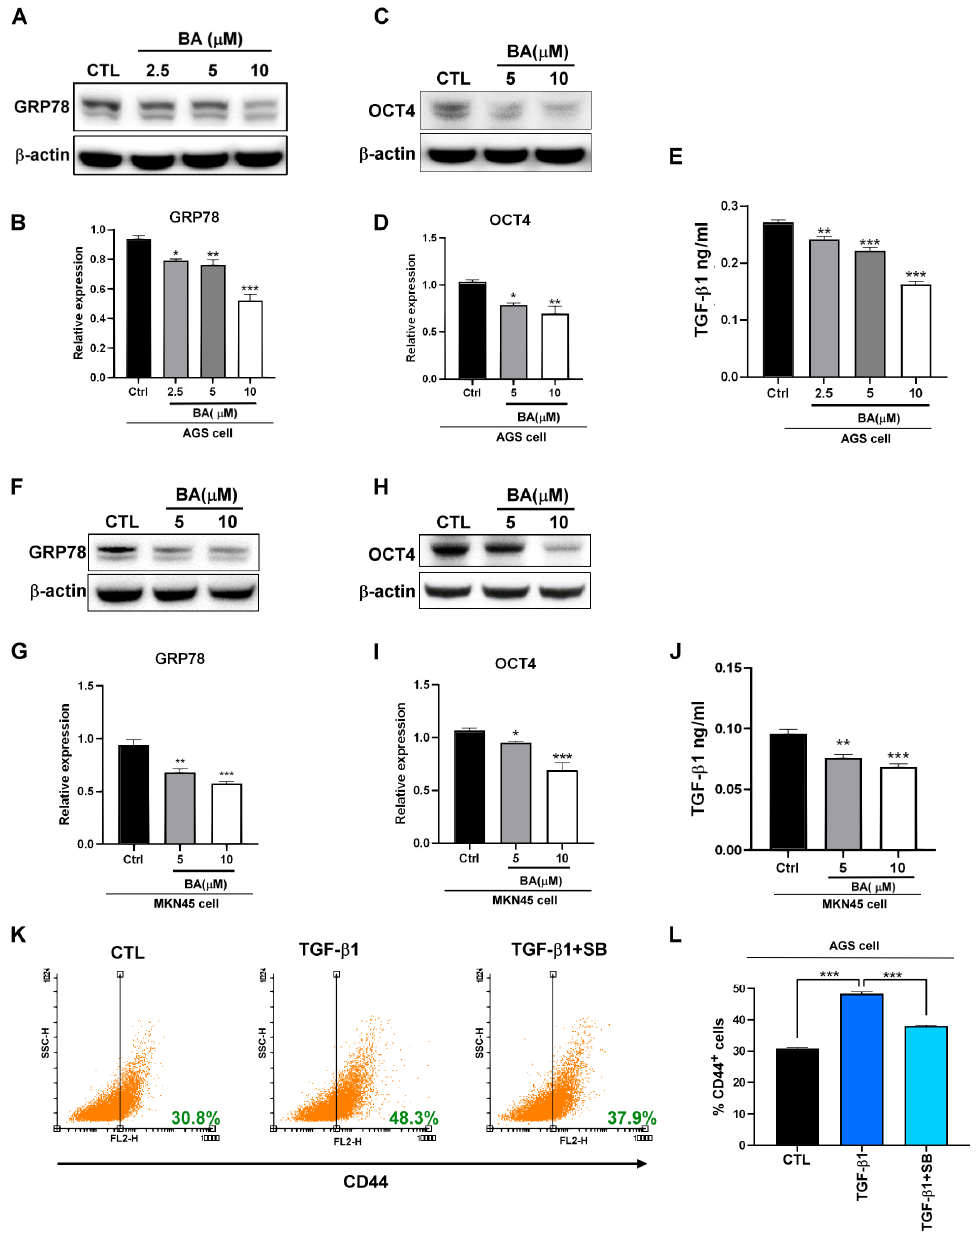
Figure 1. ( A , B ) GRP78 expression and quantification by Western blotting. Human gastric cancer AGS cells were treated with 2.5, 5, and 10 μ M BA for 72 h, which inhibited the expression of GRP78. ( C ) TGF- β 1 levels after treatment of AGS cells with 2.5, 5, and 10 μ M BA in a conditioned medium. ( D , E ) OCT4 expression and quantification by Western blotting after treatment of AGS cells with 5 and 10 μ M BA for 72 h. ( F , G ) GRP78 expression and quantification by Western blotting after treatment of MKN45 cells with 5 and 10 μ M BA for 72 h. ( H , I ) OCT4 expression and quantification by Western blotting after treatment of MKN45 cells with 5 and 10 μ M BA for 72 h. ( J ) TGF- β 1 levels in media conditioned after treatment of MKN45 cells with BA. ( K , L ) CD44 + AGS cells analyzed using flow cytometry after treatment with 20 ng/mL TGF- β 1 and 10 μ M SB431542 (TGF- β receptor inhibitor) for 48 h. Data are presented as mean ± standard error of the mean (SEM) for four independent experiments. Significance was calculated using one-way ANOVA analysis: * p < 0.05, ** p < 0.01, *** p < 0.005.